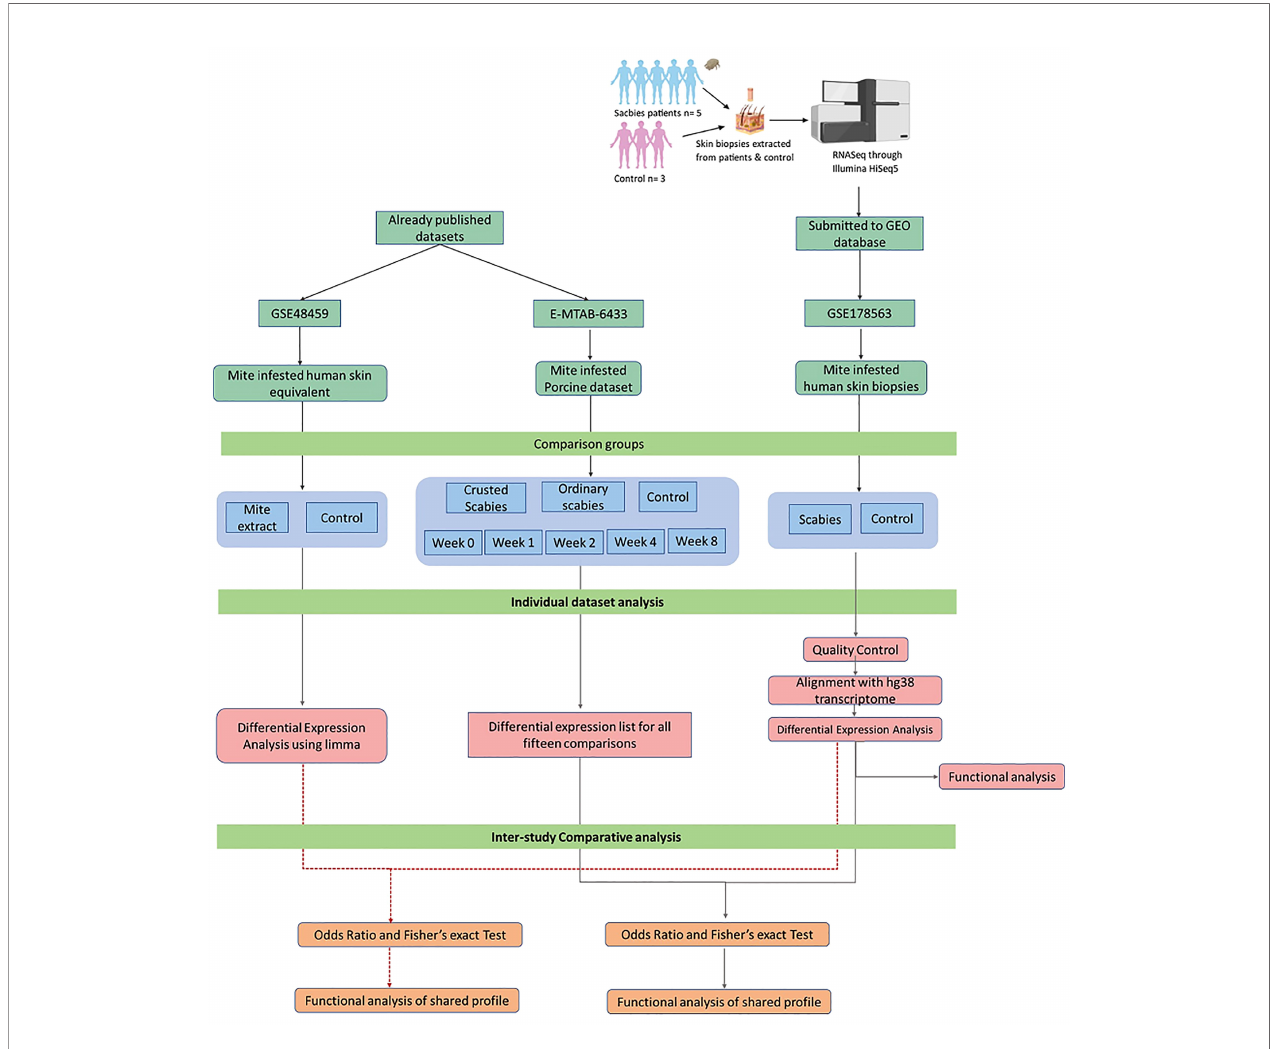
FIGURE 1 | Work fl ow of the